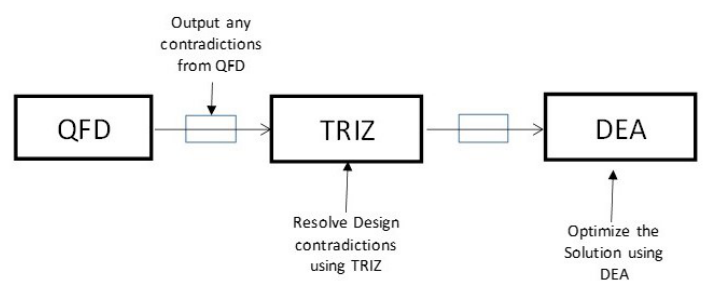
Figure 2. Integration of QFD, TRIZ, and DE